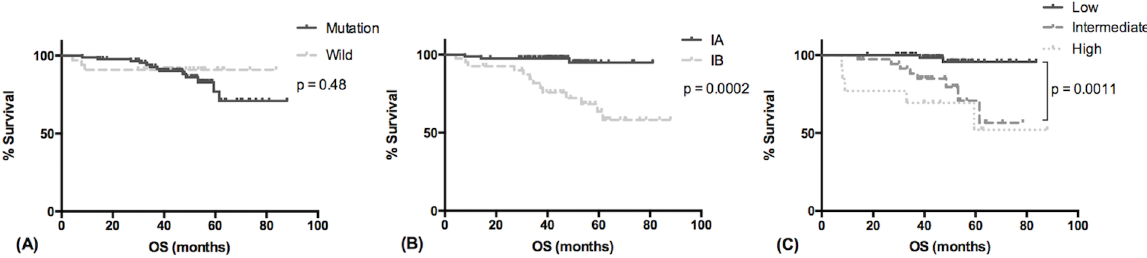
Fig 2. Overall survival of patients with stage I resectedpulmonary adenocarcinoma. (A) Overall survival in relationto EGFR mutation status. (B) Overall survival in relationto tumor pathologic stage. (C) Overall survival in relationto histological classification.